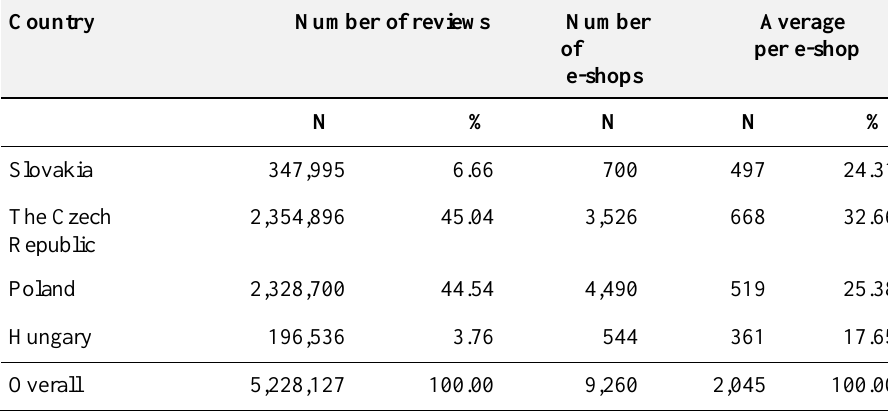
Table 2 – The total number of e-shop